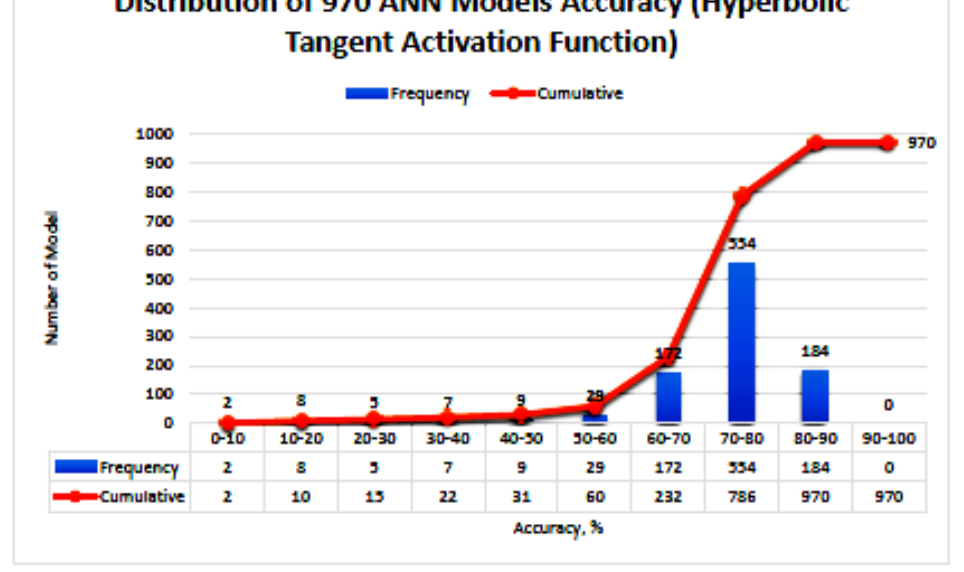
Figure 6. Histogram illustrating the distribution of accuracy among all 1000 ANN models using the hyperbolic tangent activation function.